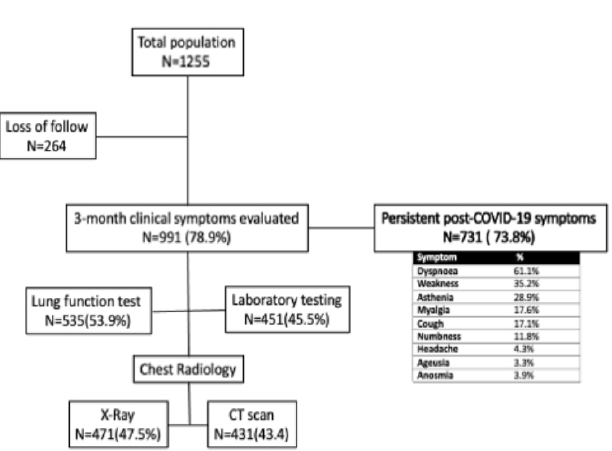
Figure 1. Flow chart and the percentage of patients with persistent port-COVID-19 symptoms.